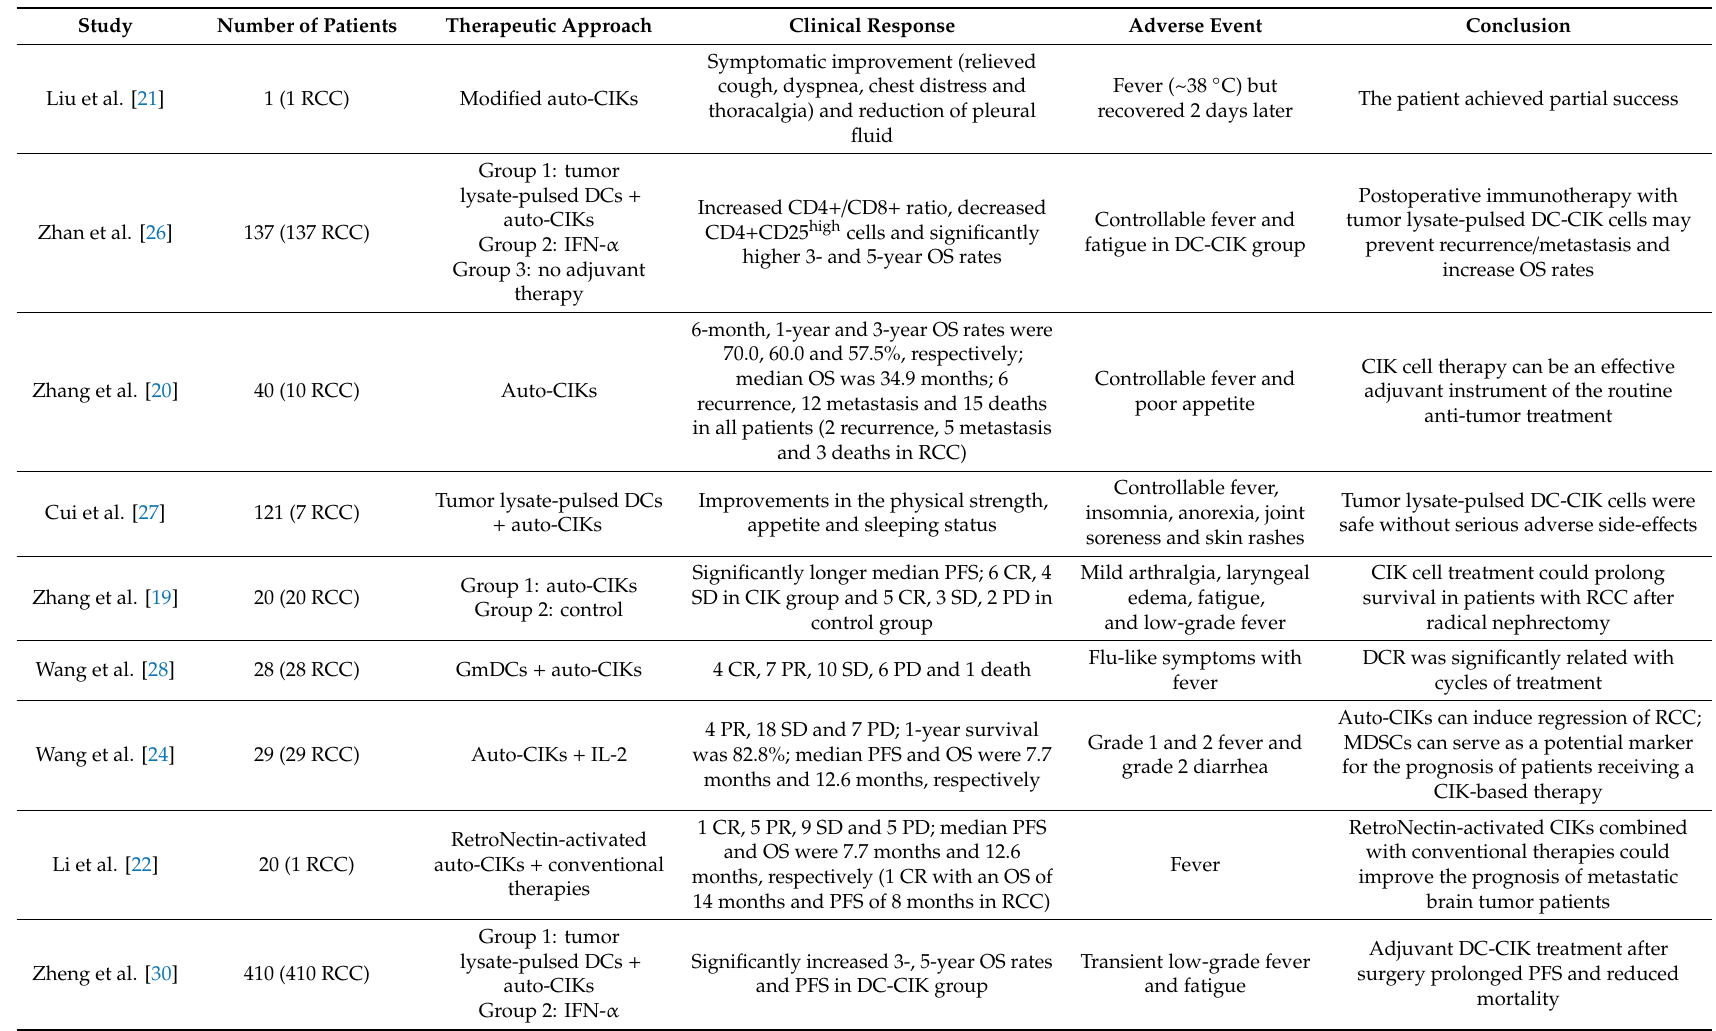
Table 1. Clinical studies applying CIK cells for the treatment of